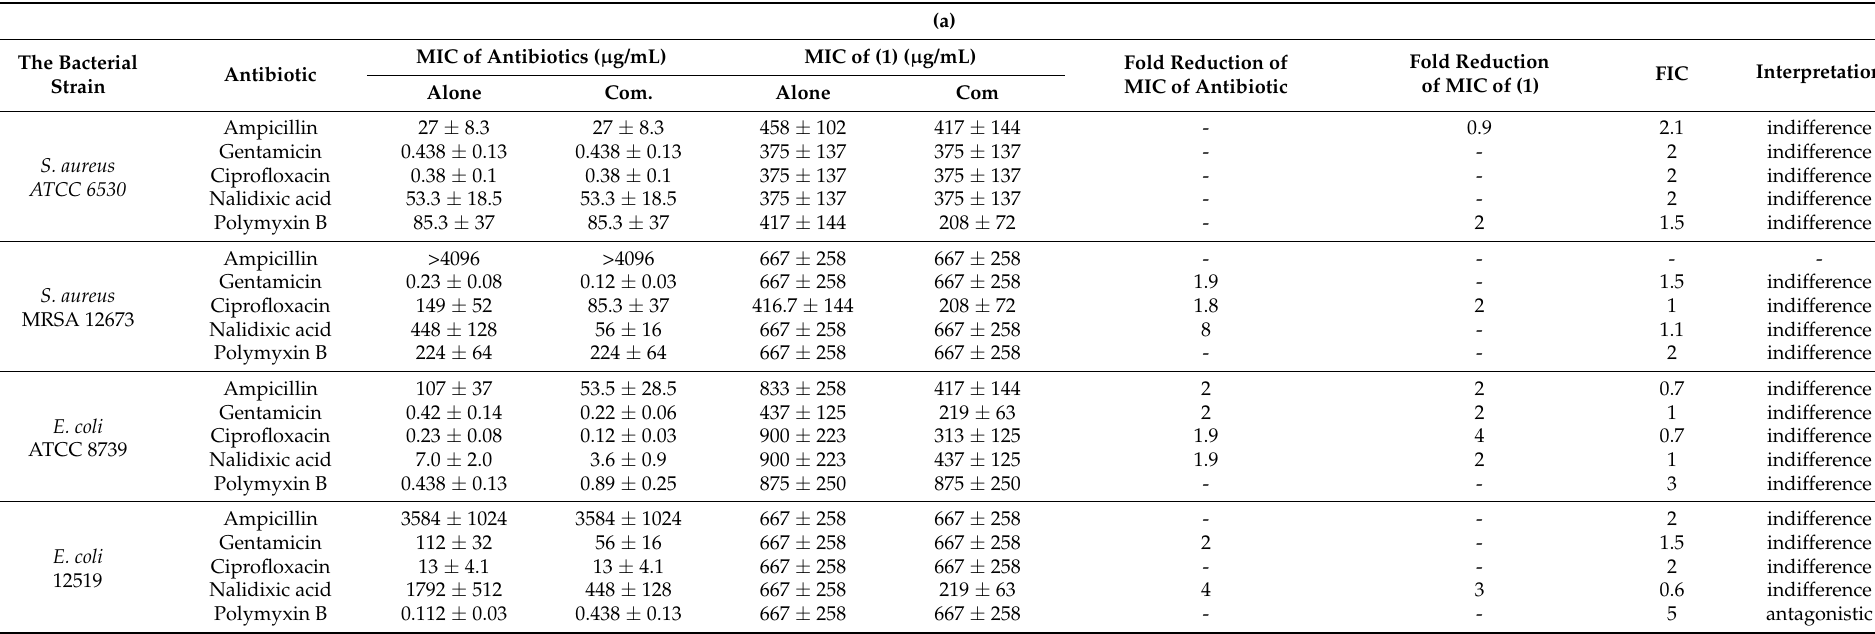
Table 3. ( a ) Fractional inhibitory concentration index (FICi) values of [CoCl 2 (dap) 2 ]Cl ( 1 ), ampicillin, gentamicin, nalidixic acid, and polymyxin B. (b) Fractional inhibitory